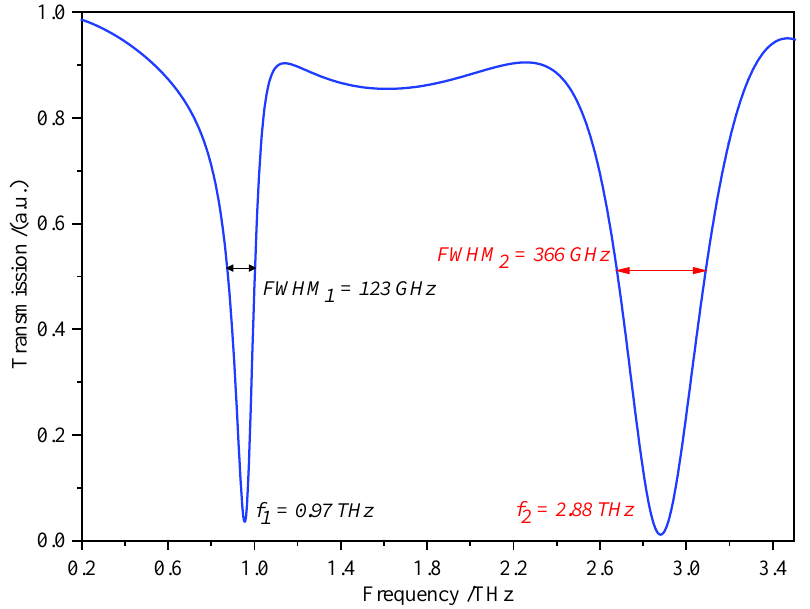
Figure 2. Simulated transmission spectrum of the proposed SMSRR. The surface electric/magnetic fields and current distribution of the terahertz metamaterial were collected at the resonant peak frequencies to elucidate the physical mechanisms of both resonant modes. The distributions of the electric field are shown in Figure 3a,b. In the low-frequency resonant mode ( f 1 ), the enhanced electric field was located at the gap of the unit structure, and the further away from the gap, the weaker the electric field was; in the high-frequency resonance mode ( f 2 ), the higher induced charges concentrated at the gap and two bulges of the inner ring, forming strong electric fields to generate dipole resonance. Figure 3c,d depict the surface magnetic fields of the metamaterial structure at two resonant frequencies, which were symmetrically distributed with the electric fields. Figure 3e exhibits the surface current distribution at f 1 , showing that the current directions are consistent throughout the metamaterial structure. The induced charges concentrated at the gap move to form an equivalent LC oscillation circuit are represented in the left bottom, while the gap on the right of the unit structure can be thought of as capacitance C , and the metallic part can be assumed as inductance L , demonstrating that the resonance at f 1 is generated by LC resonance. The frequency f 1 was determined based √ LC . According to Figure 3f, at the on the well-known resonance formula: f = 1/2 π higher resonant frequency f 2 , the current direction on the left side of the ring is opposite to that on the right side, causing the induced charges to converge at the bulges on the left side of the inner ring, forming the electric dipole shown in the lower left of the figure. At this point, the alternating electric field drove the dipole vibration, resulting in a dipole resonance. Both resonant frequencies were determined by the equivalent capacitance and inductance related to the structure of the metal unit itself